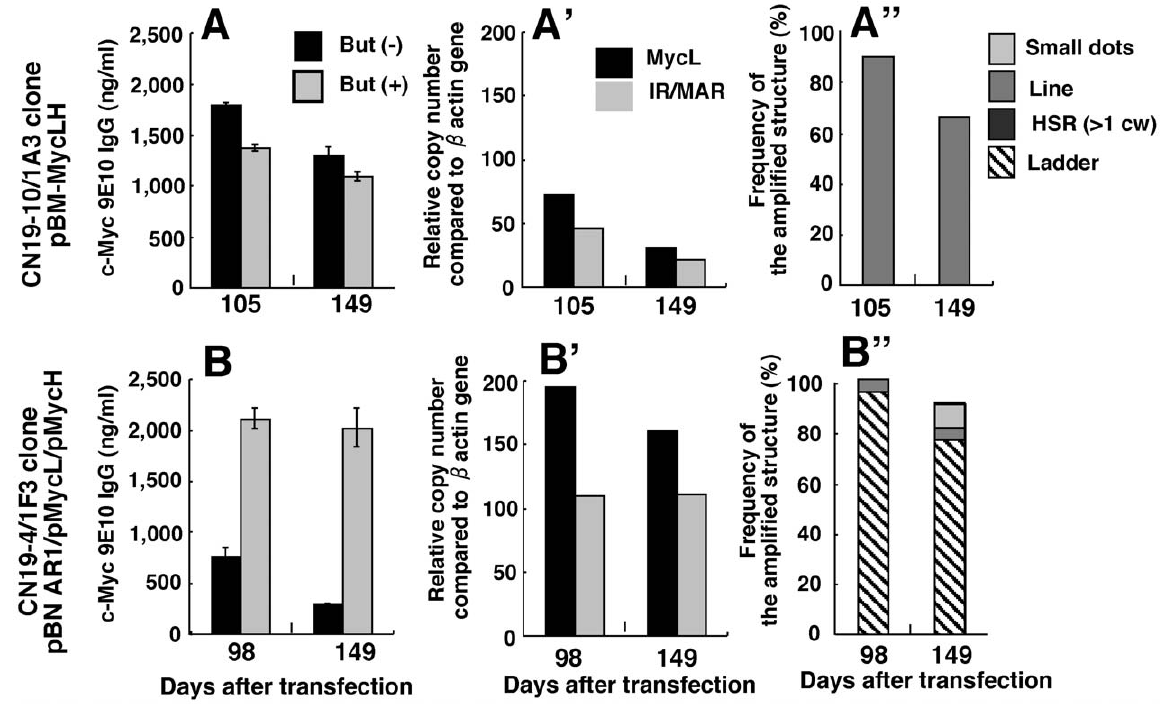
Figure 5. Clonal stability with respect to antibody expression and amplified genes. Two high-producer clones with amplified genes at a chromosomal line HSR (A; CN19-10/1A3) or a ladder HSR (B; CN19-4/1F3) were subjected to prolonged culture. The antibody expression in the presence or absence of butyrate (A, B), the copy number of the Ig -light chain ( MycL ) and the IR sequence per cell (A’, B’), and the amplified structure were examined by ELISA, real-time PCR and FISH, respectively, at the days after the plasmid transfection that were noted in the